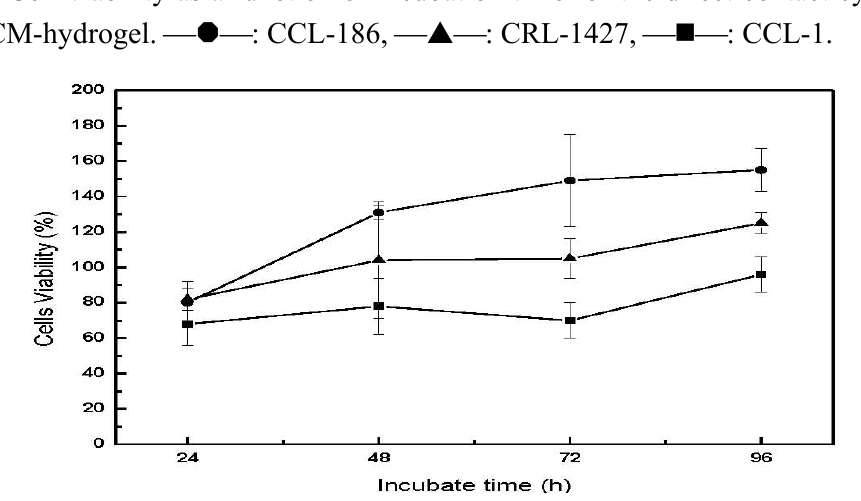
Figure 9. Cell viability as a function of incubation time for the direct contact cytotoxicity